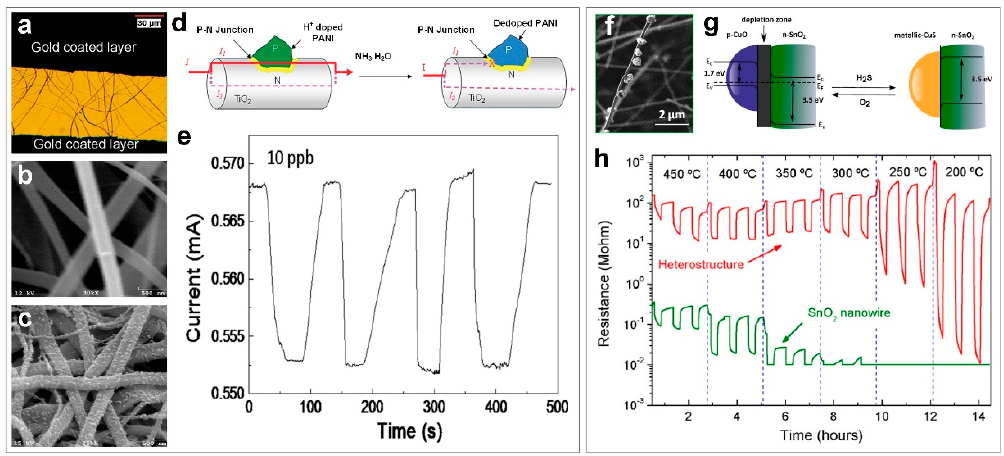
Figure 5. ( a ) An optical microscope image of the fabricated CuO/SnO 2 sensor and ( b ) high-magnification scanning electron microscopy images of TiO 2 microfibers and ( c ) TiO 2 microfibers enchased with PANI nanograins. ( d ) Schematic of nanosized p-n heterojunction as a switch to control the electric current flow in TiO 2 microfibers. ( e ) Sensor’s reproducibility upon exposure to 10 ppb NH 3 gas [54]. ( f ) SEM image of p-CuO particles onto a single SnO 2 nanowire. ( g ) General sketch of the heterostructure: p-CuO particles on the n-SnO2 surface create a p-n junction. The depleted region reduces the effective conduction channel in the nanowire, which leads to a higher resistance. After H 2 S sensing, p-CuO particles change to metallic CuS, which result in a breakup of the p-n junction, a wider conduction channel in the nanowire, and, as a consequence, a lower resistance value. ( h ) Response of p-CuO/n-SnO 2 heterostructures and bare SnO 2 nanowires to 2 ppm H 2 S at different temperatures [42].